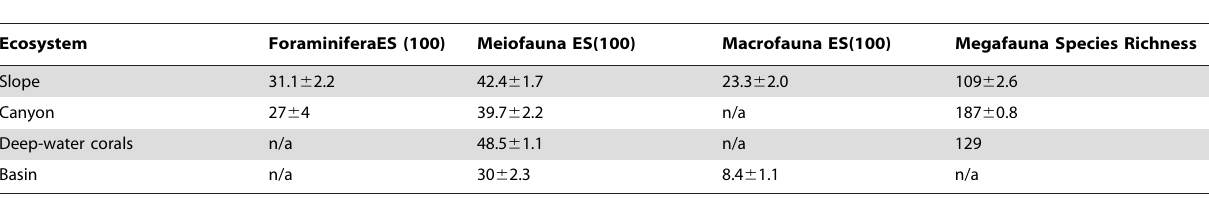
Table 1. Biodiversity of different deep-water habitats in the Mediterranean